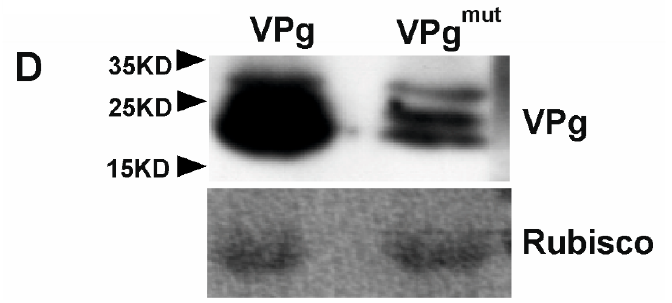
Figure 4. eIF4E-bidning motif YXXXXL Φ is required in the in trans expressed VPg for enhanced PVA WT 3’RLUC expression and RNA stabilization. Normalized 3’RLUC activity and RNA accumulation from ( A ) PVA WT , ( B ) PVA Δ GDD and ( C ) PVA VPgmut was determined in the presence of ectopically expressed GUS, VPg and VPg mut at 3 dpi. Experiments were performed at least in triplicate. Data represent one representative experiment, and the bars display mean ± S.D ( n = 3 or more). A Student’s t-test shows which of the samples were significantly different compared to the GUS control; p -values < 0.05 are indicated with *, and p- values < 0.01 are indicated with **. ( D ) Samples collected from N. benthamiana leaves that were infiltrated with Agrobacterium carrying VPg and VPg mut expression constructs (OD 600 0.5) at 3 dpi were subjected to a Western blot analysis with anti-VPg antibodies to verify VPg/VPg mut accumulation.